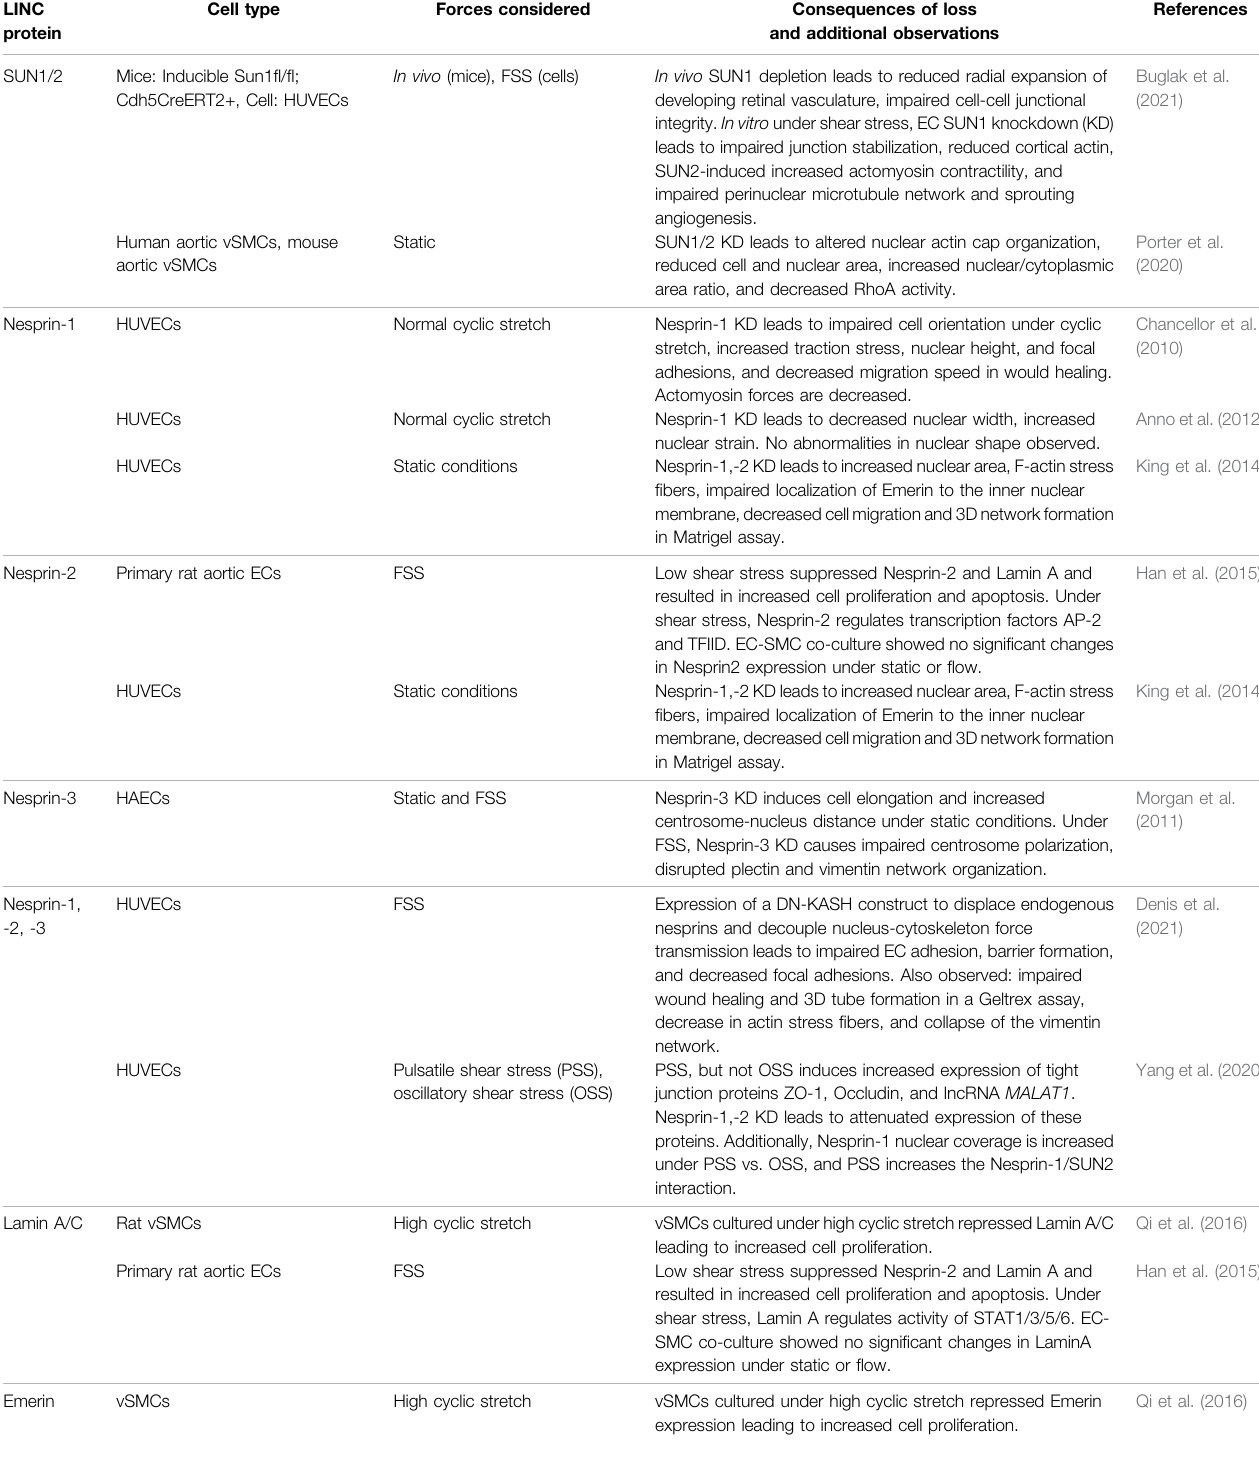
TABLE 1 | Studies evaluating functions of LINC complex proteins in vascular cells. FSS, fl uid shear stress; HUVECs, human umbilical vein endothelial cells; HAECs, human aortic endothelial cells; vSMCs, vascular smooth muscle